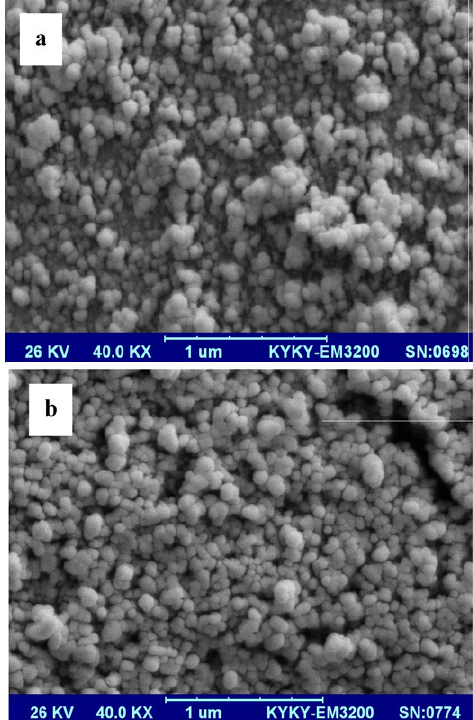
Fig. 2. SEM images of ZnO NPs at two temperatures: (a) at room temperature, (b) at 90